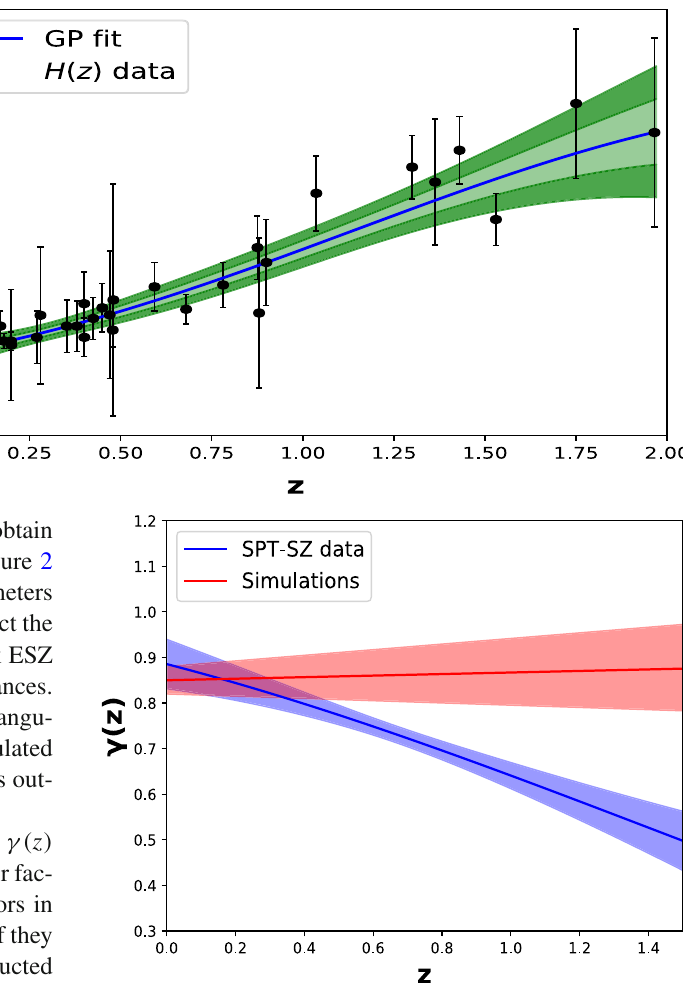
Fig. 2 Reconstruction of H ( z ) using Gaussian Processes Regression. The data points represent the 31 H ( z ) cosmic chronometer measurements taken from Li et al. [60]. The blue line indicates the best GP fit to data along with 1 σ and 2 σ error bands shown by two different shades of green bands